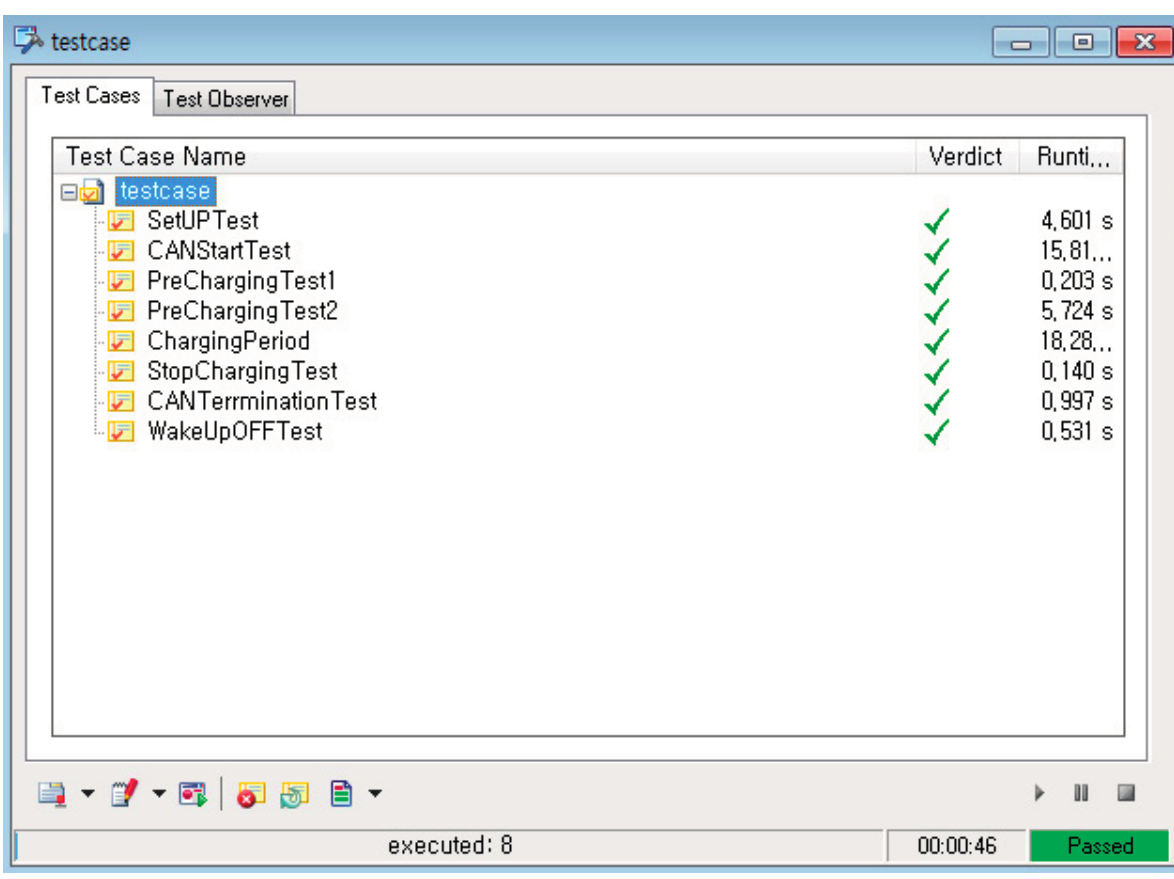
Figure 6. Test runner in CANoe after successfully testing the normal charging